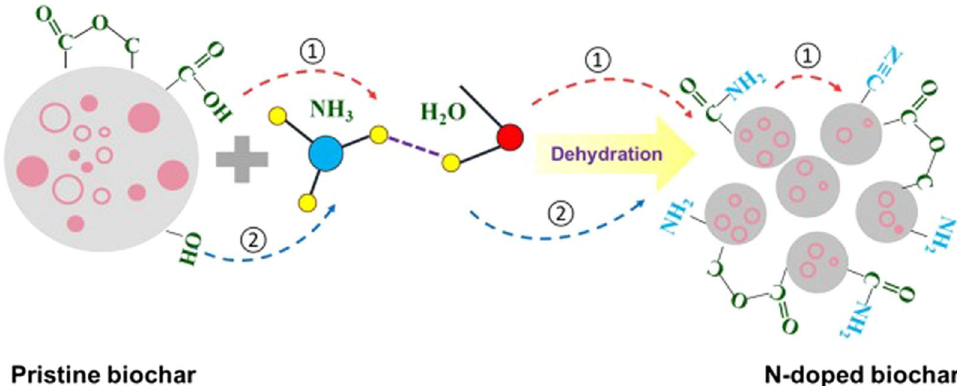
Fig. 4 Mechanisms of doping nitrogen in biochar by ball milling in the presence of ammonium hydroxide. (Adapted from Xu et al. (2019) with copyright permission from